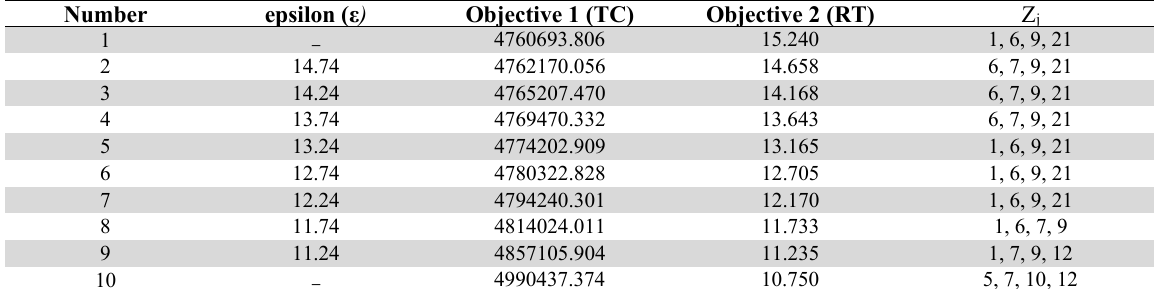
Results of solving the model for different values of epsilon via the new